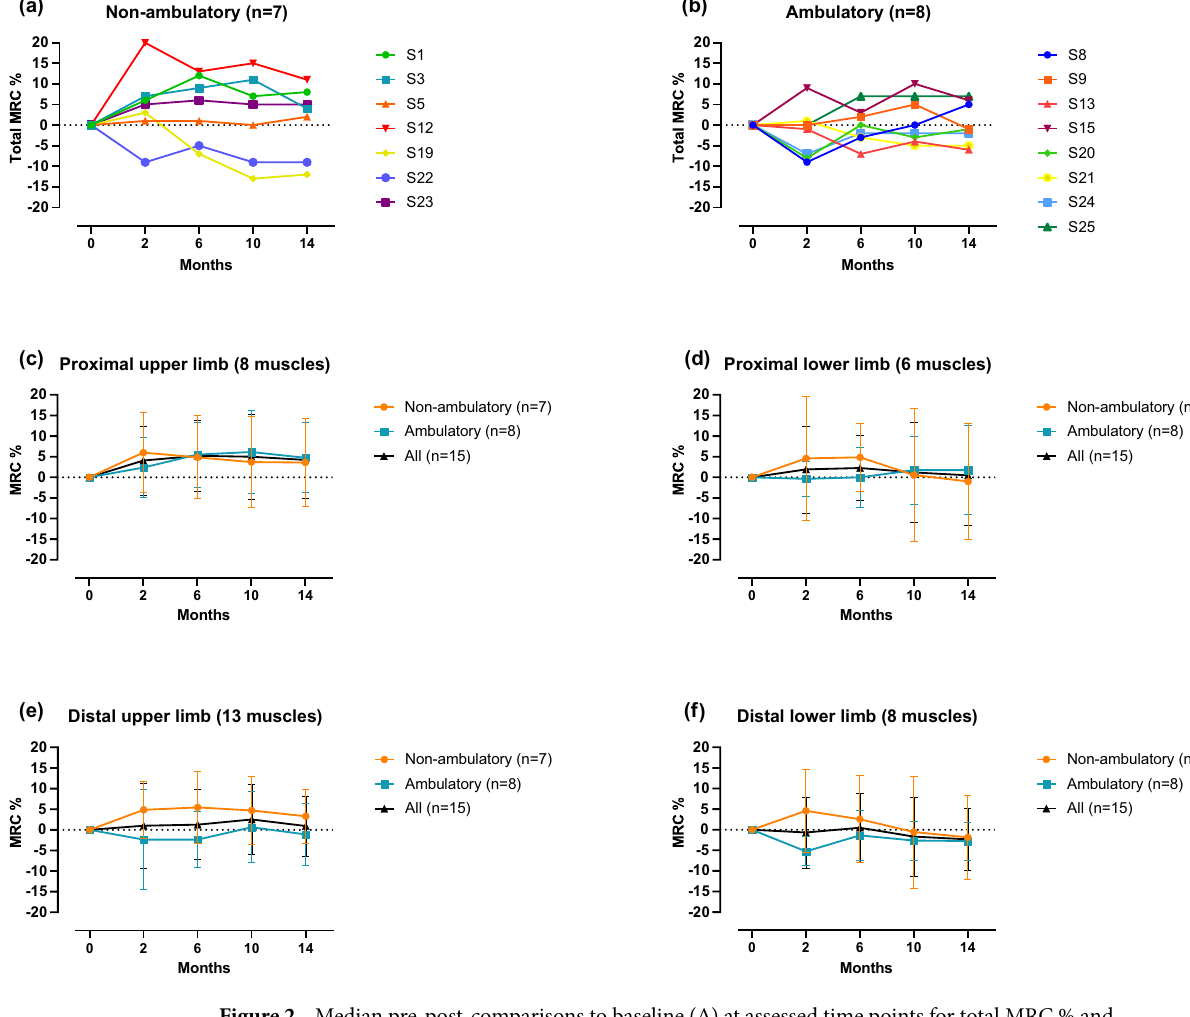
Figure 2. Median pre-post-comparisons to baseline (Δ) at assessed time points for total MRC % and subdomains during nusinersen therapy. Error bars indicate the interquartile range. ( a , b ) Individual trajectories of assessed patients for non-ambulatory ( a ) and ambulatory ( b ) patients showed a marked variability of treatment responses. The n-number indicates the number of analysed individuals. Patients’ pseudonyms are listed alongside the graphs (e.g. S1). ( c – f ) Depiction of MRC % changes in subdomains over time in ambulatory vs non-ambulatory patients and the overall cohort. Numbers in brackets indicate the number of muscle functions included in that specific subdomain. Improvements in both patient subgroups were observed in the proximal muscles of the upper limb ( c ). Muscle strength showed no relevant changes in the lower limbs with temporary increases above the threshold of non-ambulatory patients shortly after the loading dosing ( d , f ) regressing during further therapy. At month two distal muscle strength of ambulatory patients worsened ( e , f ), but the initial decline lessened over